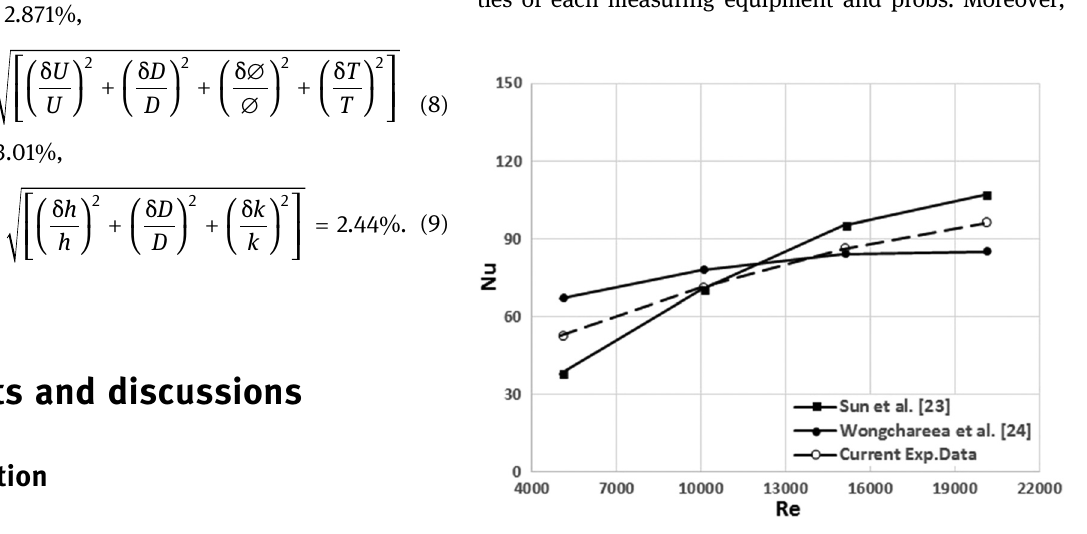
Figure 6: Current validation with both Sun et al. [ 22 ] and Wong